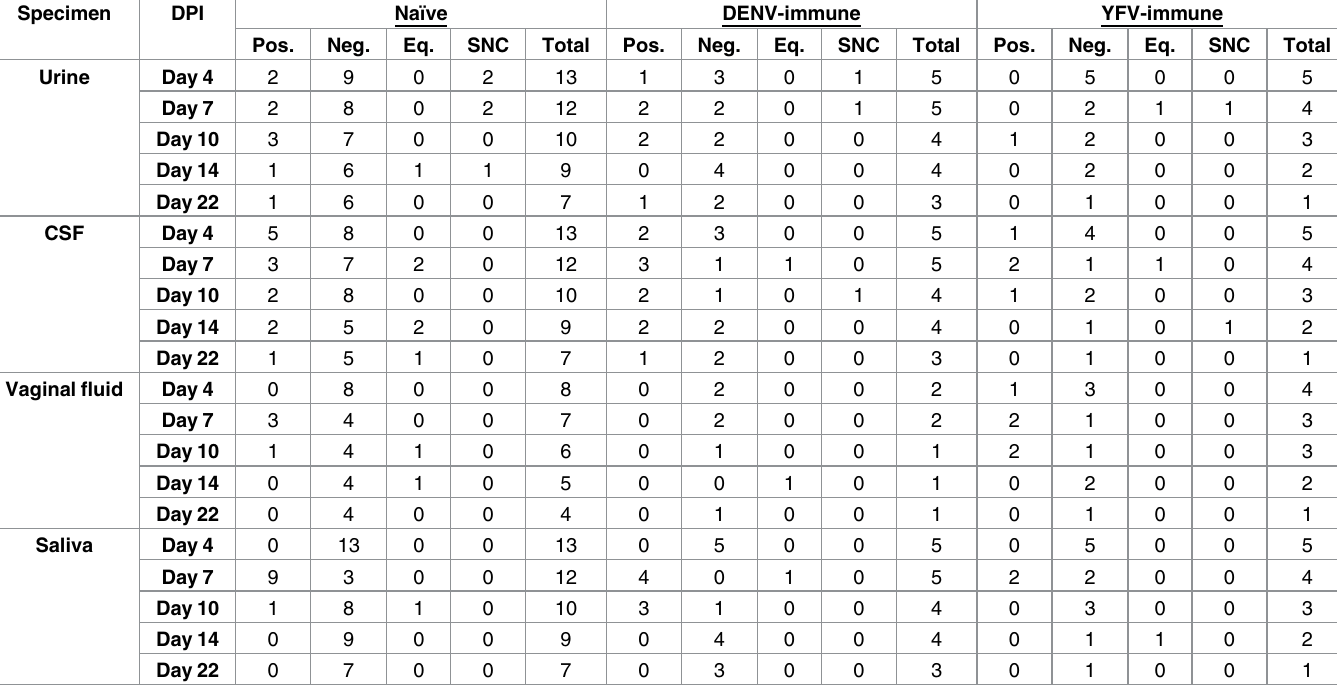
Table 1. Distribution of ZIKV in biofluids determined by RT-qPCR. Specimen Urine